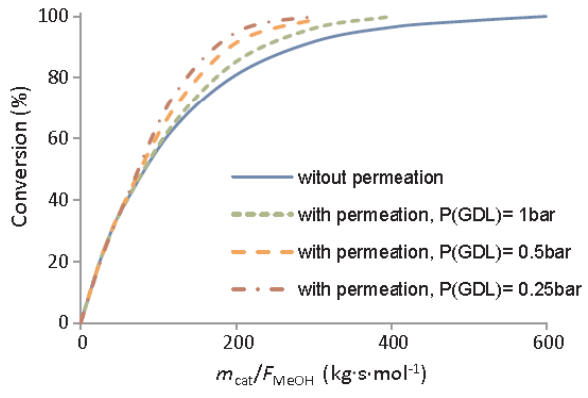
Figure 16. Simulated methanol conversion vs space-time in a Pd-Ag MR, at 200 °C, total retentate pressure of 3.0 bar. With permission of reprint of Elsevier from Ribeirinha et al. [63].